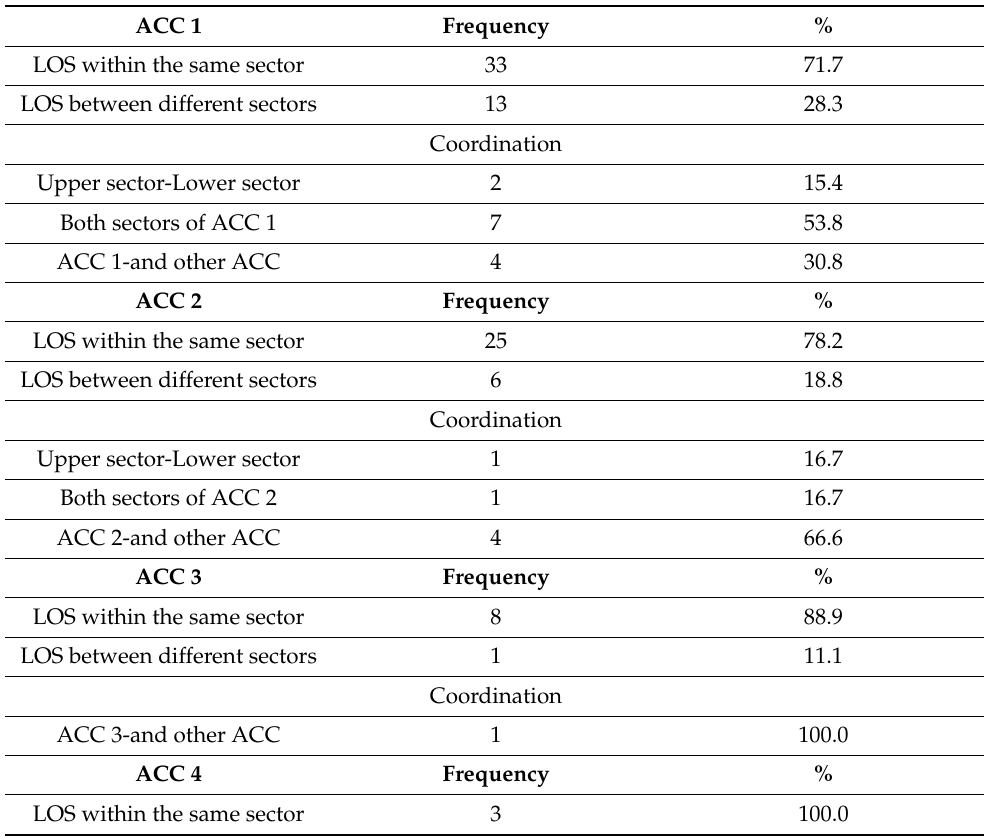
Table 6. Incident characterization according to where it occurred (single control sector/more than one sector